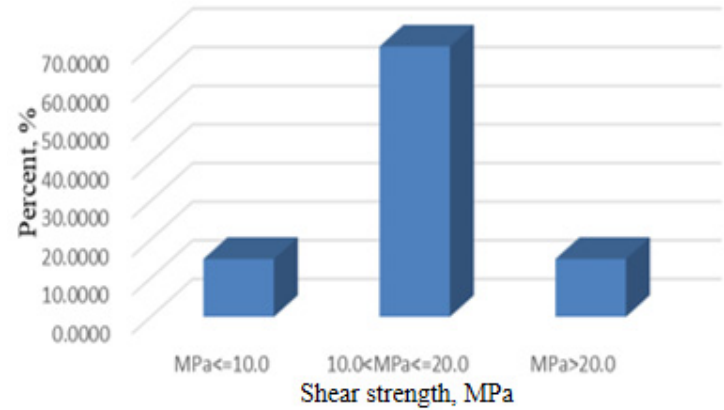
Processes 2023 , 11 , x FOR PEER REVIEW Figure 5. Frequency histogram of shear strength range. Figure 5. Frequency histogram of shear strength range. Figure 5. Frequency histogram of shear strength range.